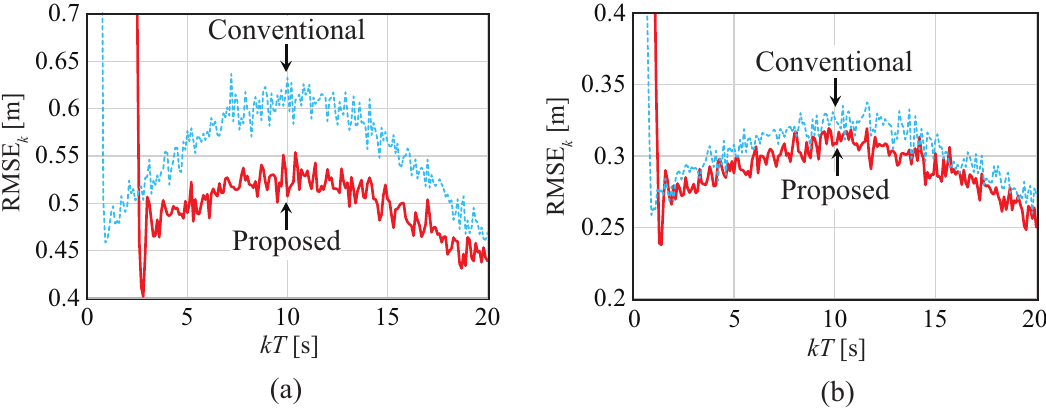
Figure 4. Simulation results for c RD = − 0.5 ( a ) and 0.5 ( b